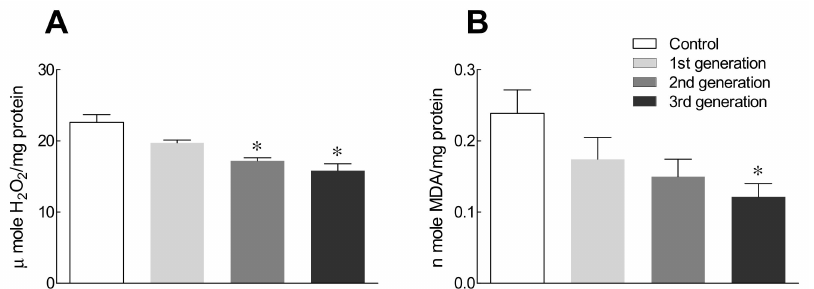
Figure 5. Effects of the GABA/5-HTP mixture (1.0% and 0.1%, respectively) on the amount of hydrogen peroxide ( A ) and lipid peroxidation ( B ) in Drosophila fly heads across generations. Data are presented as means ± standard error of the mean for each group ( n = 50 per group). The different letters indicate significant (* p < 0.05) differences from the control group by Student’s t -test. H 2 O 2 , hydrogen peroxide; MDA,